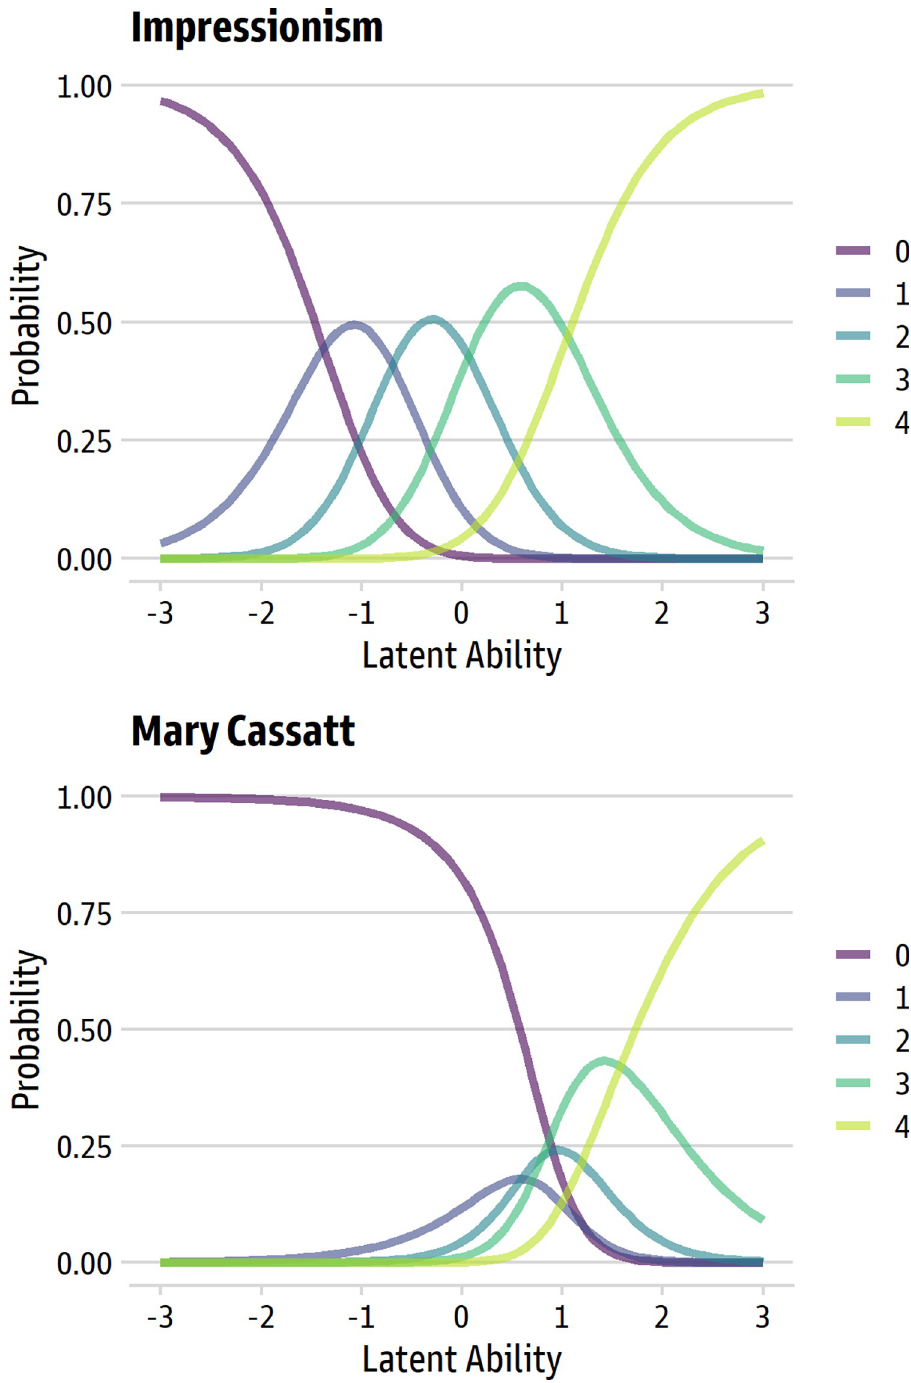
Fig 1. Examples of ordered and disordered thresholds for two items from the original Aesthetic Fluency Scale. The top panel (“Impressionism”) shows ordered category thresholds; the bottom panel (“Mary Cassatt”) shows disordered thresholds typical of items for the original